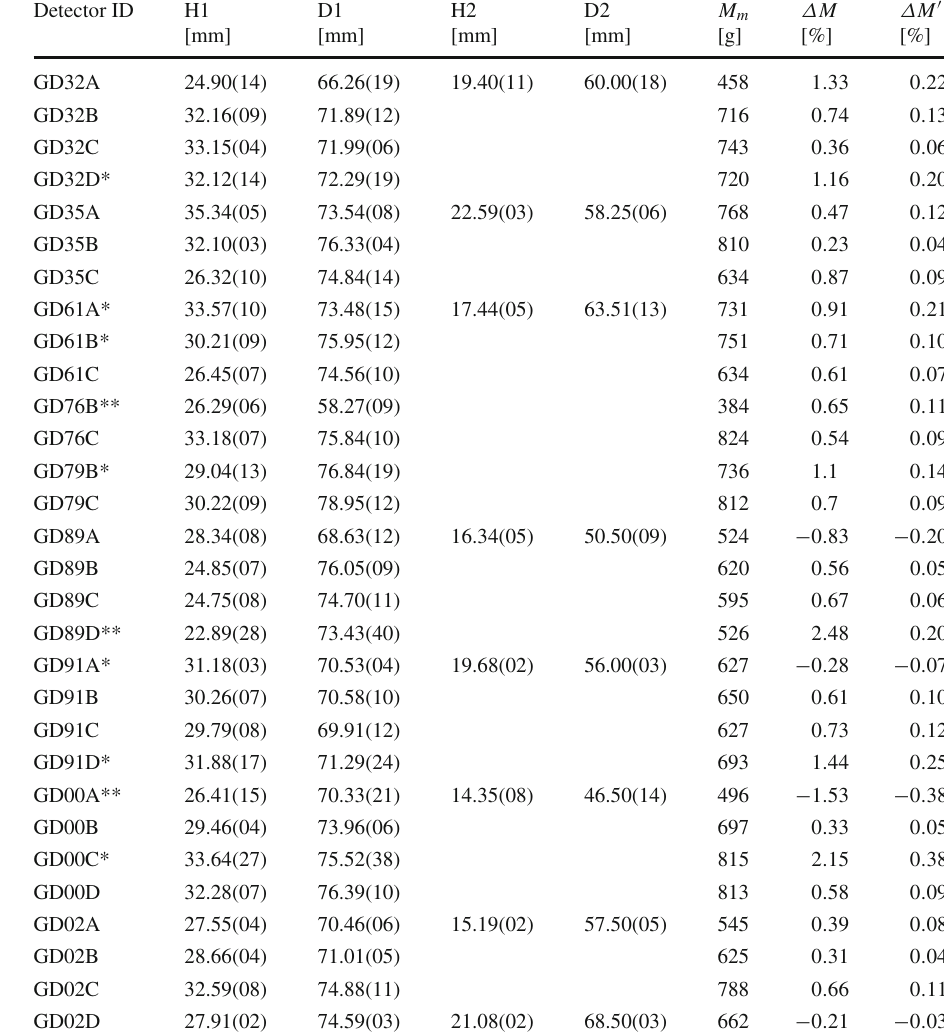
Table 5 Overall dimensions and masses of the 30 Gerda Phase II BEGe diodes as defined by the Gerda